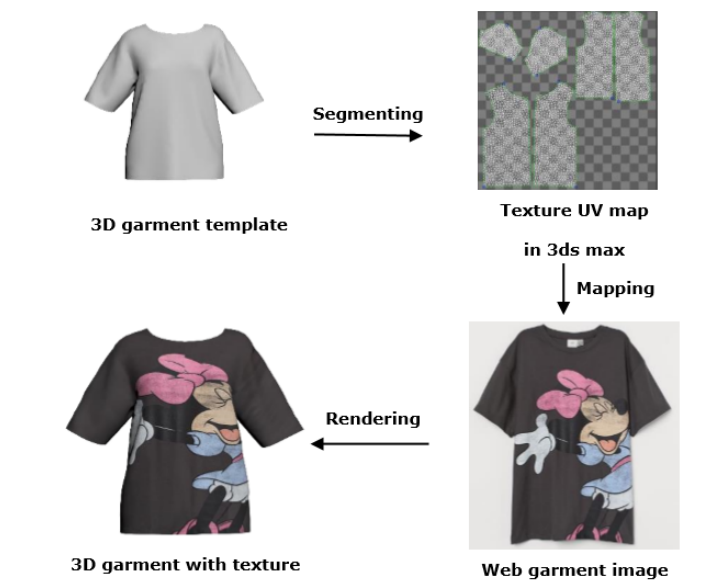
Figure 8. Mapping web garment image to generated 3D garment